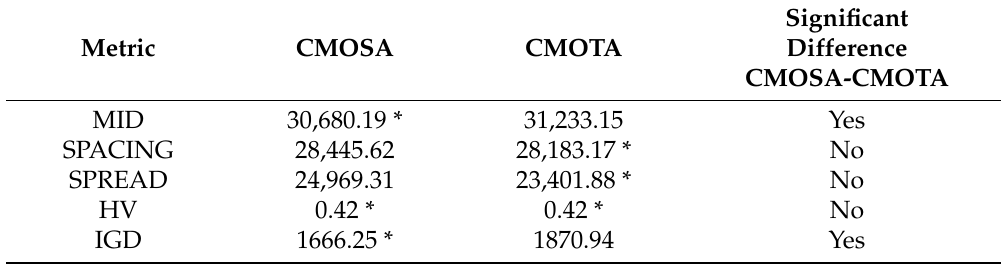
Table 4. Results obtained by the metrics for 70 instances.